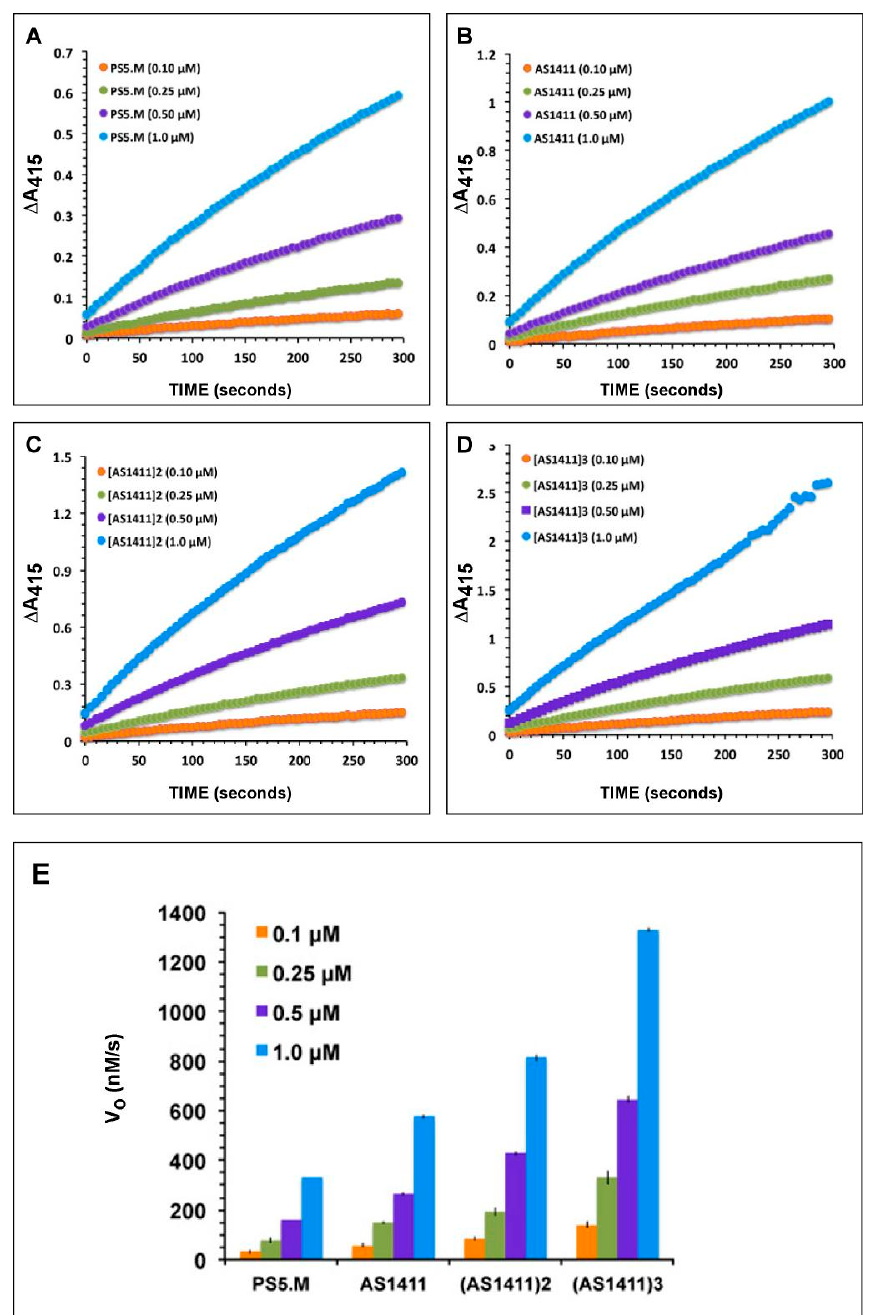
Figure 4. Effect of DNAzyme concentrations on activities of AS1411 multimers and PS5.M. ( A ) PS5.M; ( B ) AS1411 monomer; ( C ) AS1411 dimer; ( D ) AS1411 trimer. In ( A – D ), the curves show time courses of ABTS oxidation by 0.1, 0.25, 0.5, and 1.0 µ M DNAzyme. ( E ) Initial Rates (expressed as V o , nM / s) were calculated from the slope of the initial linear portion of the curves shown in ( A – D